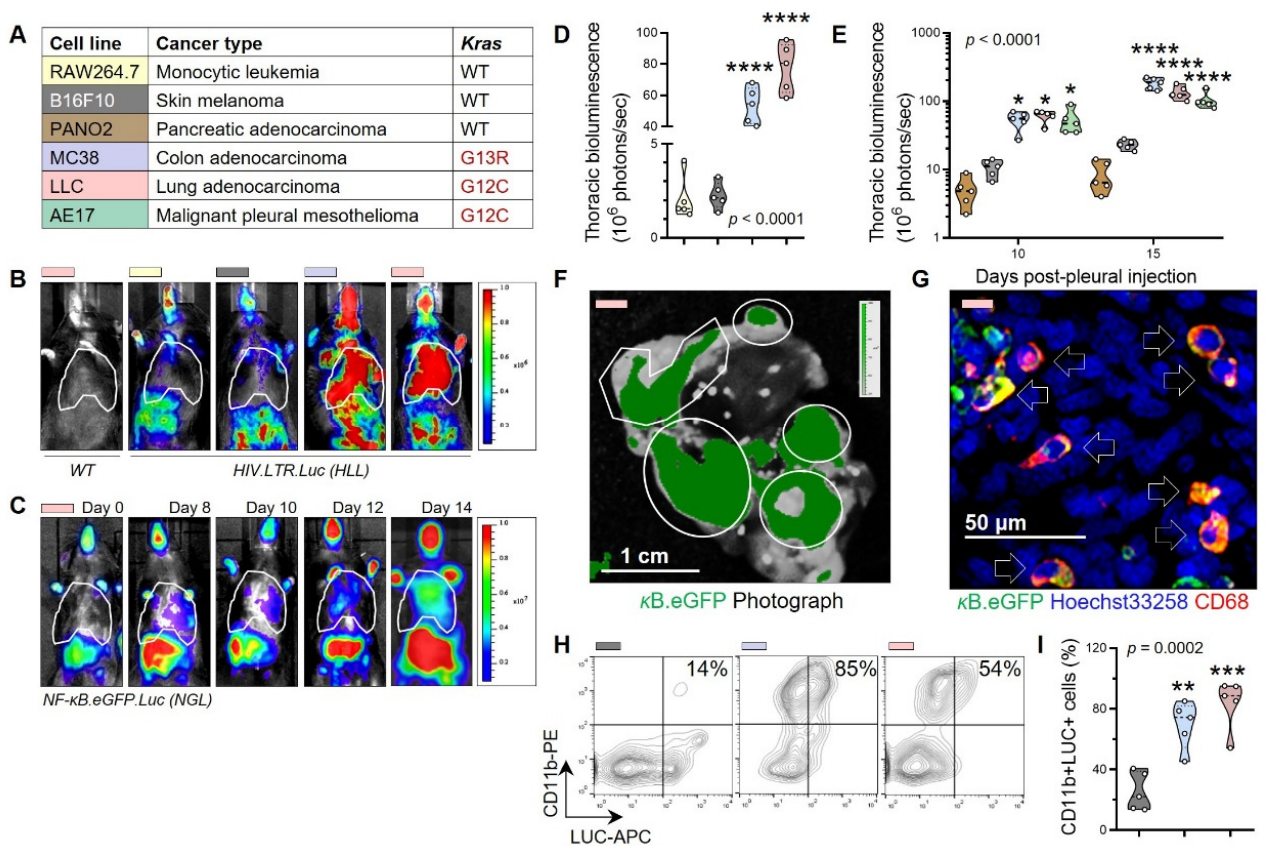
Figure 2. Kras -mutant tumors activate NF- κ B in tumor-infiltrating macrophages. ( A ) Color-coded cancer cell lines used with tissues of origin and Kras mutation status. ( B – E ) Bioluminescent images with pseudo color scales ( B , C ) and data summaries ( D , E ) from WT and HIV-LTR.Luciferase ( HLL : B and D ), and NF- κ B.GFP.Luciferase ( NGL ; C and E ) NF- κ B reporter mice at 14 days ( B , D ) or serial time-points ( C , E ) post-pleural injection of tumor cells. Note that in these models, bioluminescence is exclusively emitted by the host and not the tumor cells. ( B , C ) Dashed areas delineate the thorax. ( F ) Photographic/biofluorescent image overlay with pseudo color scale of NGL mouse lung explant 14 days post-pleural LLC cells shows NF- κ B reporter GFP signal ( κ B.eGFP) over pleural tumors (outlines; n = 10). ( G ) GFP immunoreactivity of pleural tumor sections co-localizes with the macrophage marker CD68 (arrows; n = 10). ( H , I ) Flow cytometric contour plots ( H ) and data summary ( I ) of pleural tumor cells from NGL mice obtained 14 days post-pleural injection stained for the myeloid marker CD11b and the κ B.LUC reporter. Percentages in ( H ) pertain to CD11b+LUC+ cells. Data in ( D , E , I ) are given as raw data (circles), median (dashed lines), quartiles (dotted lines), and kernel density distributions (violin plots) color-coded as in ( A ). Sample size ( n ) = 5–10/group; p , probability, one- or two-way ANOVA; *, **, ***, and ****, p < 0.05, p < 0.01, p < 0.001, and p < 0.0001, respectively, compared with mice injected with RAW264.7, PANO2, or B16F10 cells at the same time-points, Bonferroni